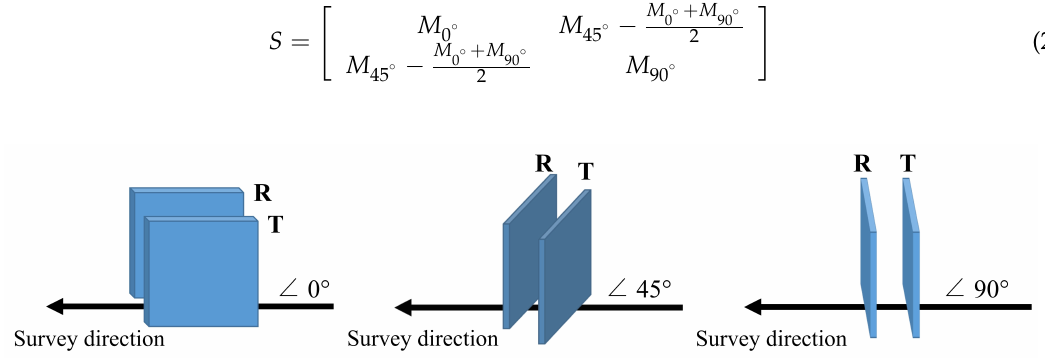
Figure 16. Three measuring methods with different measuring angles.